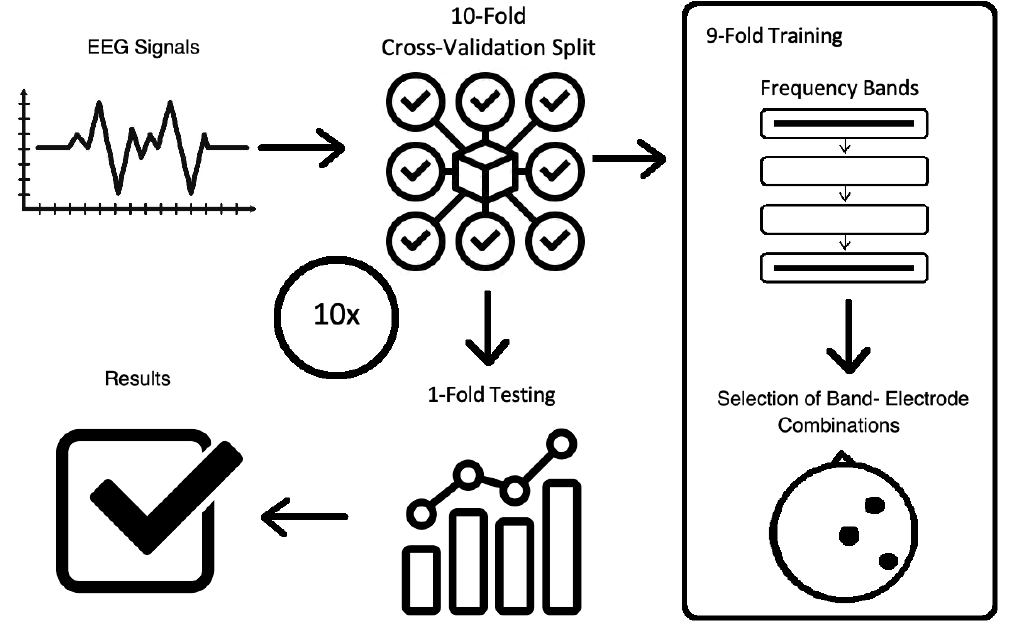
Figure 2. The overview of the